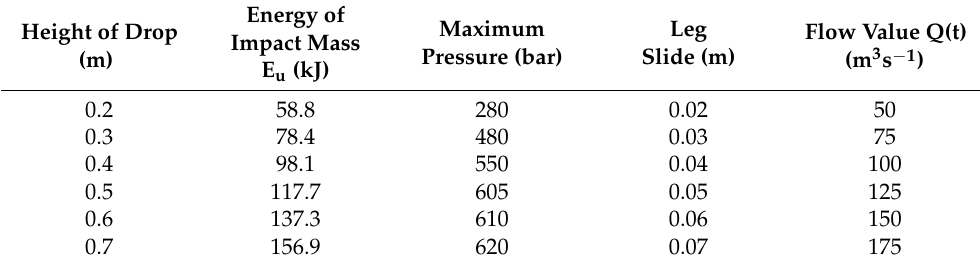
Table 1. Flow value occurring in the safety